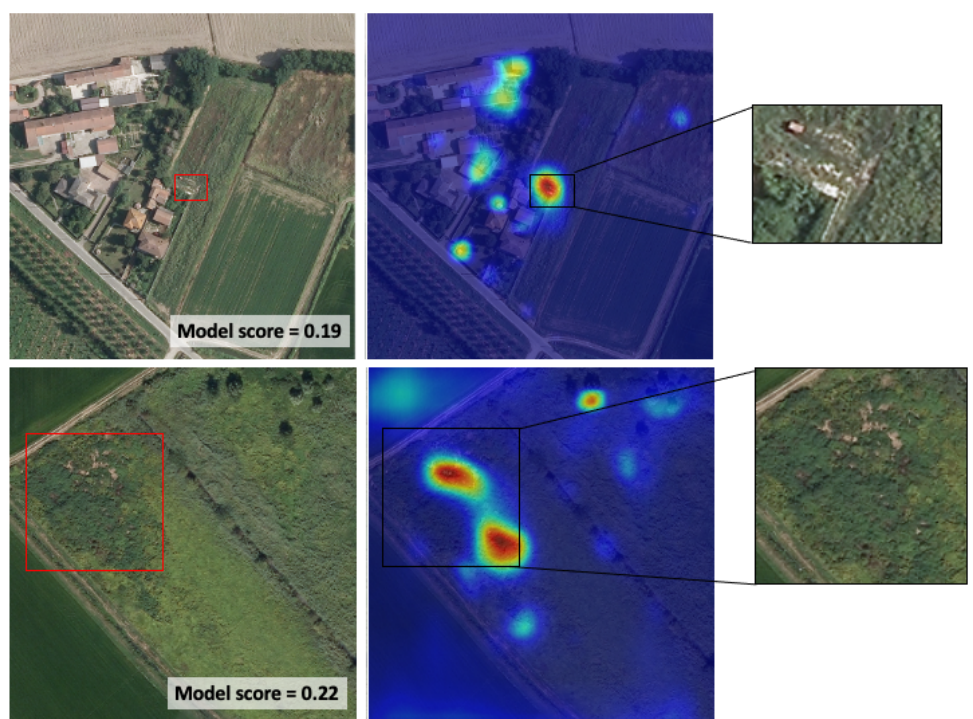
Figure 8. Examples of sites labeled as positive by the expert photo interpreter but classified as negative by the